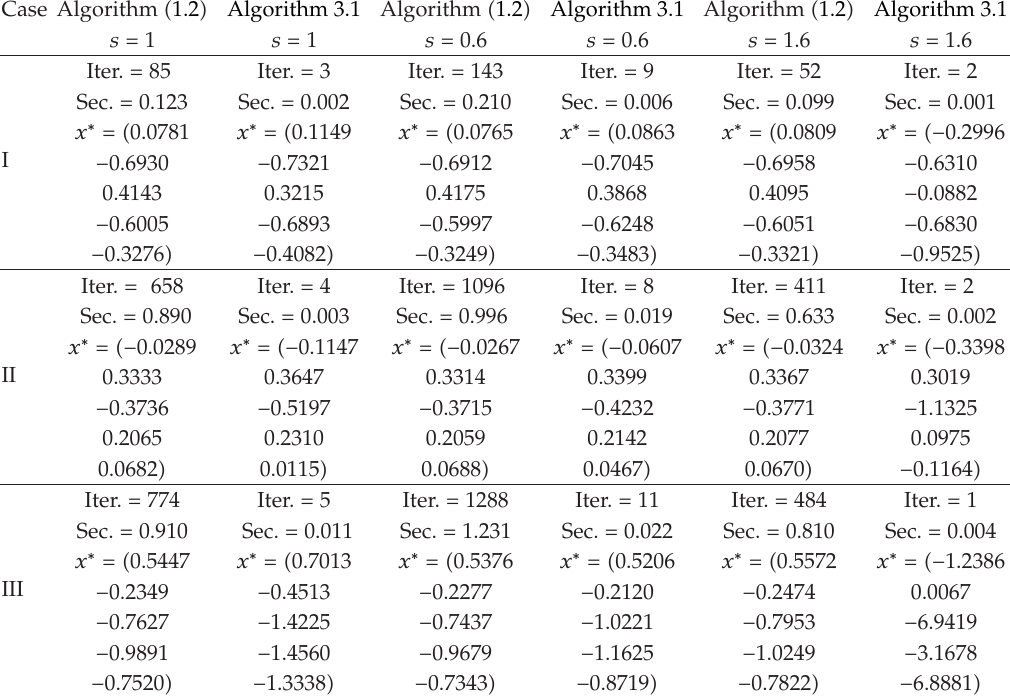
Table 1: The numerical results of Example 4.1.